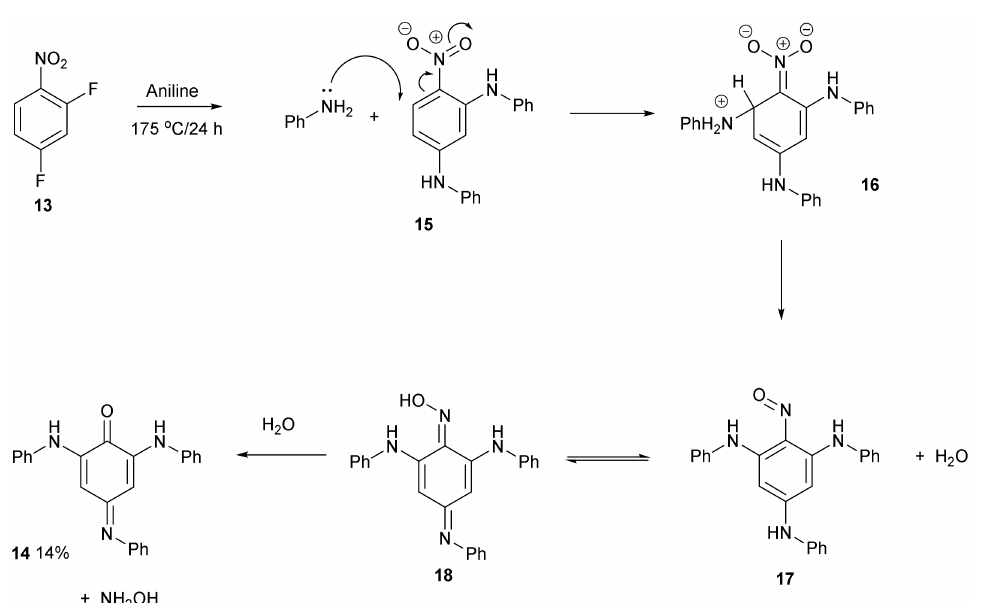
Figure 5. Proposed mechanistic scheme for the formation of compound 14 .